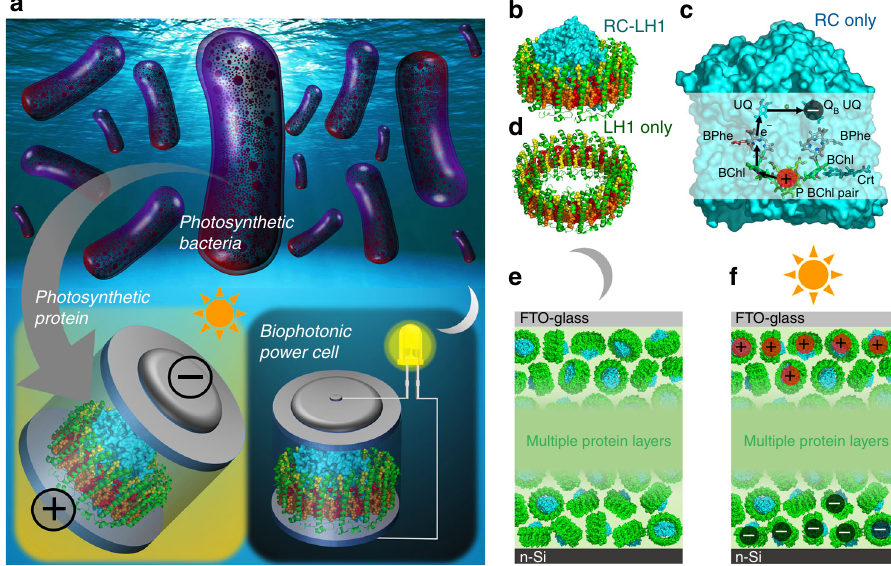
Fig. 1 Photosynthetic proteins, charge separation, and cell architecture. a Cartoon illustrating the concept of a biophotonic power cell based on natural photosynthetic components. b The RC-LH1 complex comprises a central reaction centre (RC) charge separation domain (cyan) surrounded by a cylindrical light harvesting (LH1) domain. c The RC can be isolated as a separate complex and is shown as a solid object with a transparent surface in the plane of the membrane to reveal the electron transfer cofactors. Photoexcitation of the P bacteriochlorophyll (BChl) pair initiates a four-step charge separation via a BChl, bacteriopheophytin (BPhe) and ubiquinone (UQ) to reduce the Q B UQ on the opposite side of the photosynthetic membrane. d The LH1 cylinder can be isolated as a separate complex and is formed from 32 BChls (alternating red/orange) and 32 carotenoids (yellow) held in place by a protein scaffold (green). e Assembled cells comprised a multilayer of puri fi ed RC-LH1 proteins (green LH1 with cyan RC) sandwiched between n-Si and FTO-glass electrodes. f Under illumination a photovoltage is produced due to light-activated protein/electrode redox interactions, but current does not fl ow through the protein multilayer in the absence of mobile